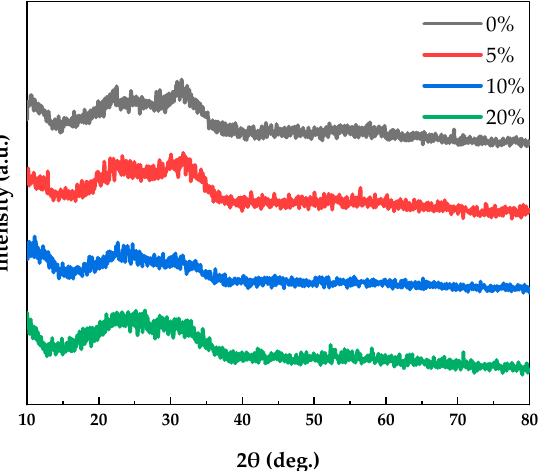
Figure 3. X-ray diffraction (XRD) patterns of PrIZO thin films prepared under various oxygen partial pressures.